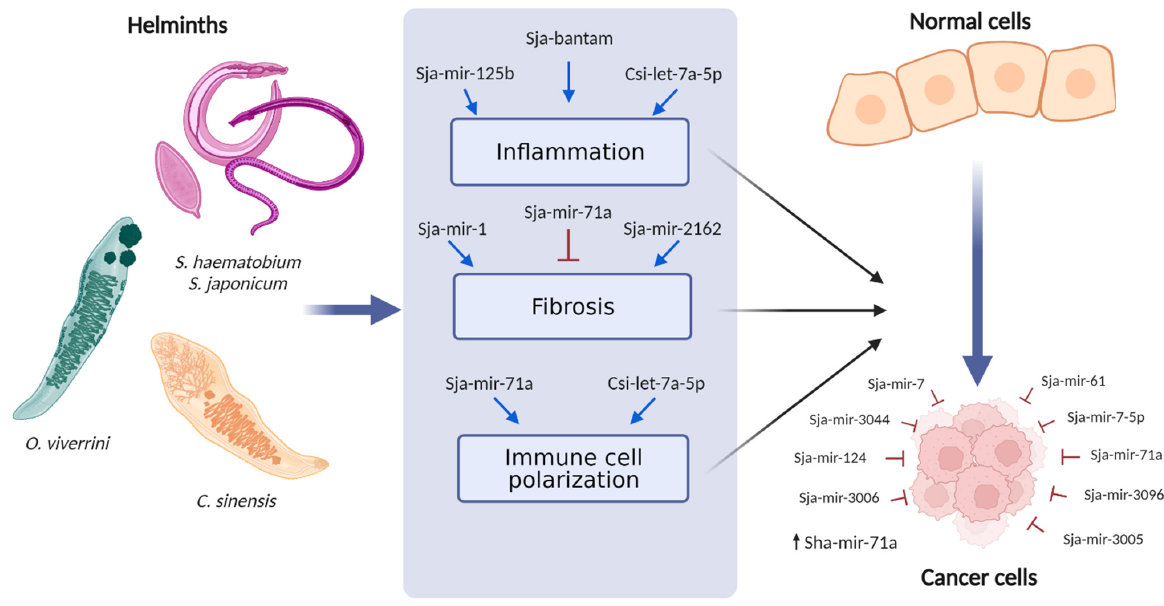
Figure 1. Helminths may promote tumorigenesis through different processes such as chronic inflammation; the polarization of immune cells such as macrophages and T cells; or by inducing persistent injury in the tissues, which can lead to undesirable effects such as fibrosis. miRNAs expressed and secreted by helminths involved in human cancer can modulate these processes. Some helminth miRNAs have shown direct antitumoral activity. miRNAs from parasites could be useful in therapy and diagnostics; for example, an miRNA of S. haematobium (Sha-mir-71a) is abundant in the urine of patients with bladder cancer associated with infection. Created using BioRender.com.